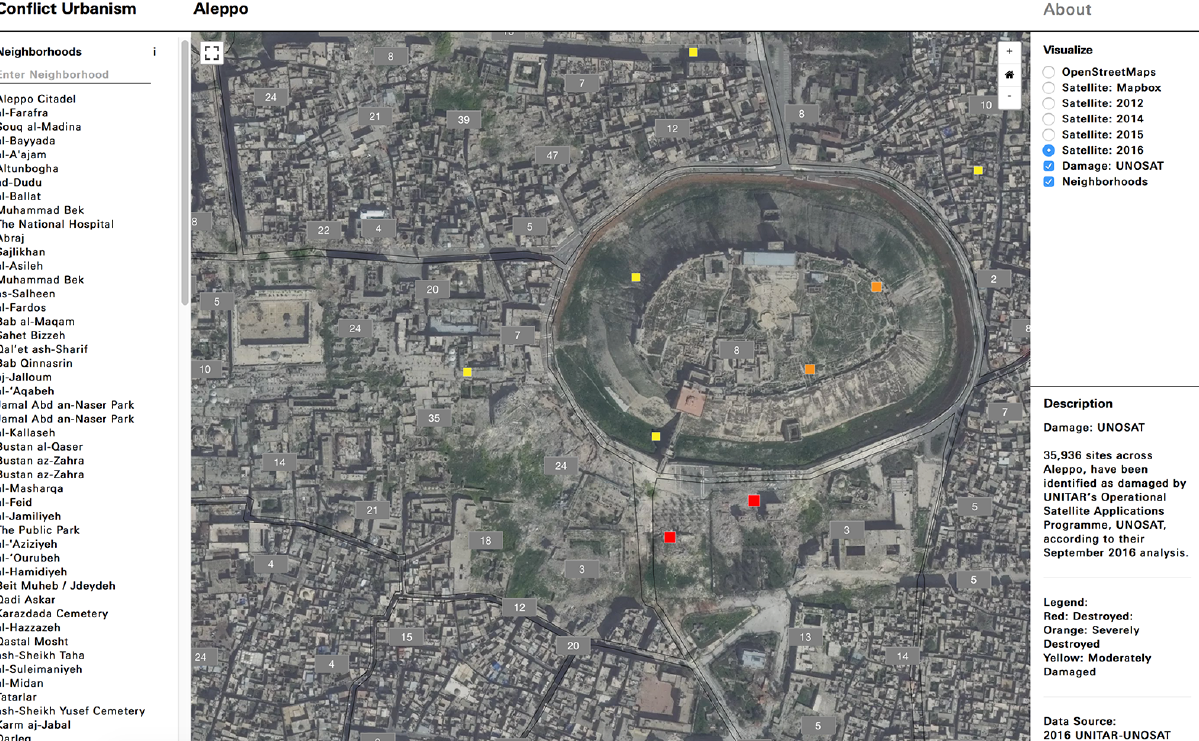
Figure 3. Interactive map of Aleppo that allows users to browse by neighborhood. Satellite images from World View II © Digital Globe 2015 &